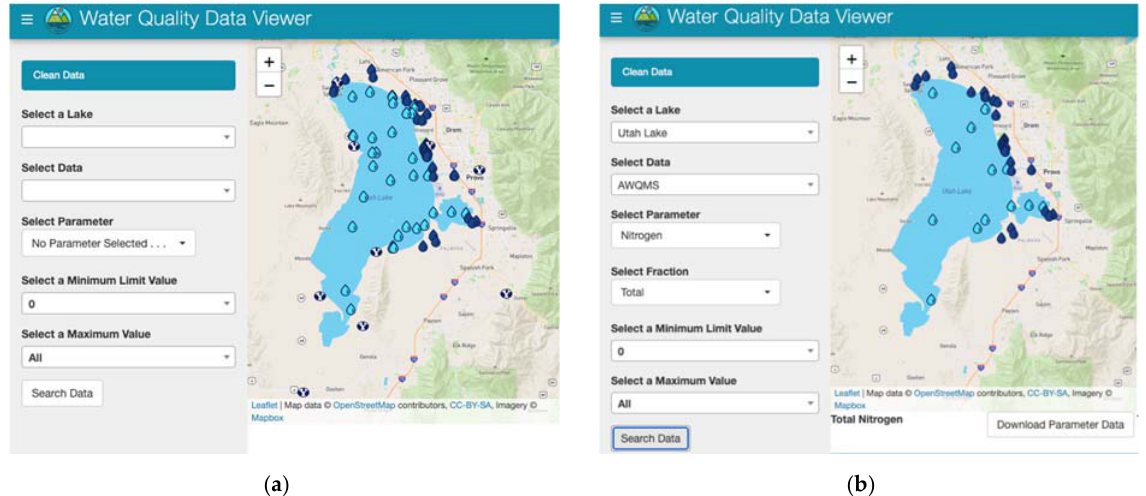
Figure 7. Utah Lake ( a ) All lake stations; ( b ) Stations with Total Nitrogen data from